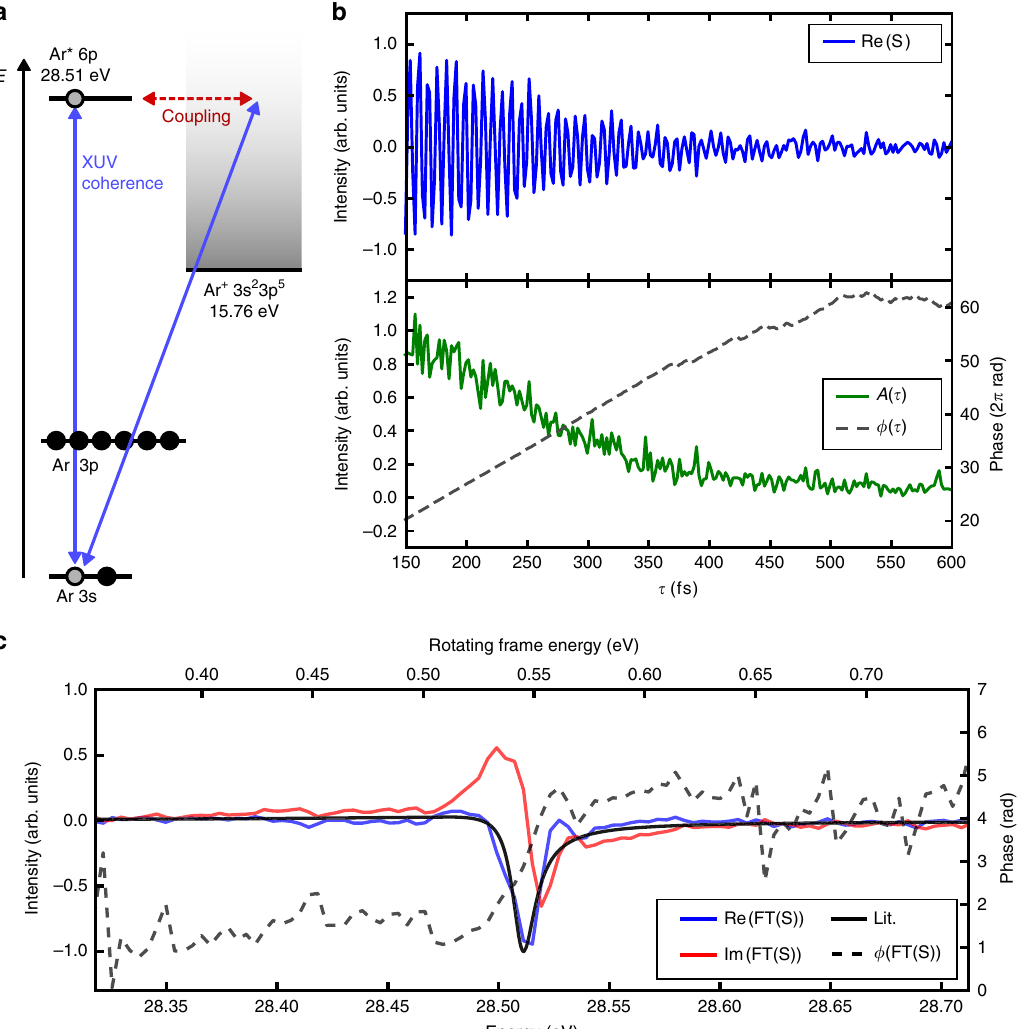
Fig. 4 Phase-resolved real-time dephasing of a Fano resonance in argon. a Excitation scheme for preparation and probing of the Ar 3s-6p inner subshell- valence coherence. b Decay of the 3s-6p coherence in the time domain, with real part of the complex signal S = A ( τ ) e i ϕ ( τ ) (blue) and its decomposition into amplitude A ( τ ) (green) and phase ϕ ( τ ) (dashed-gray). c Linear susceptibility of the process obtained from Fourier transform of the signal: Absorption (blue) and dispersion (red) curve compared to the Fano lineshape from ref. 29 (black) and spectral phase ϕ ( ω ) (dashed gray), exhibiting a characteristic phase jump at the resonance of ≈ π